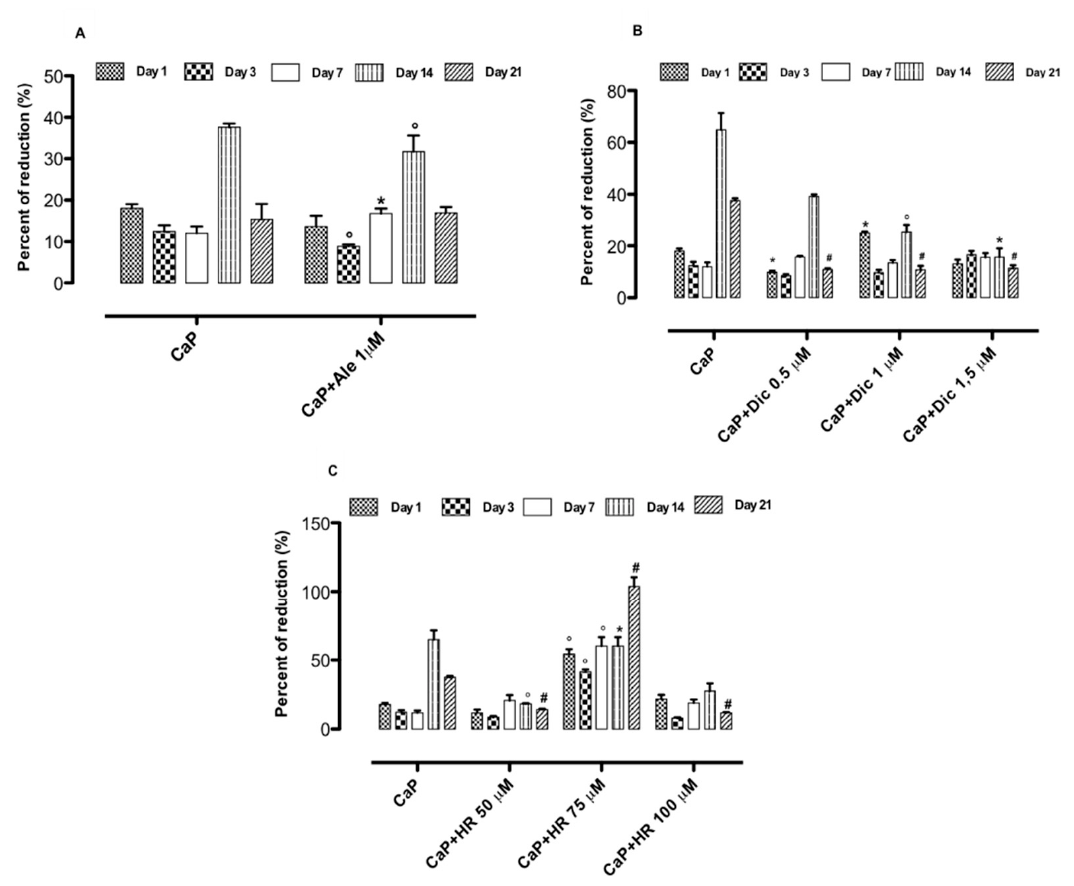
Figure 3. Alamar Blue percent of reduction measured after 1, 3, 7, 14, and 21 days of cell–materials interaction: CaP + Ale ( A ), CaP + Dic ( B ), CaP + HR ( C ). Data represent mean ± dev.st. of 3 independent experiments ( n = 6). * p < 0.05; ◦ p < 0.01; # p < 0.001 vs. CaP. Ale: alendronate, Dic: diclofenac sodium, HR: harpagoside.